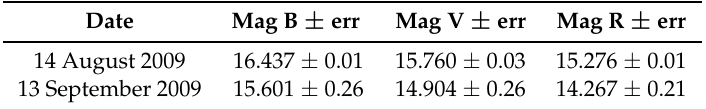
Table 5. Magnitudes B, V, and R with errors at each epoch obtained from differential photometry using the Bruce L. Gary and Hereford